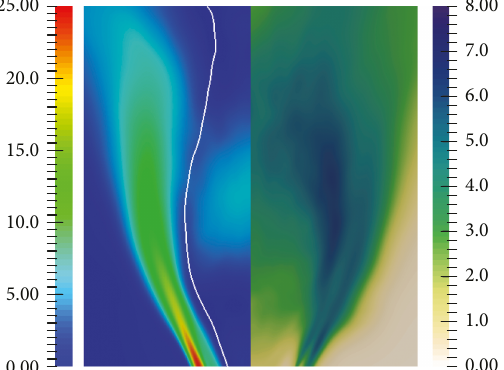
Figure 6: Mean ( r < 0mm ) and rms ( r > 0 mm ) velocity behind the blu ff